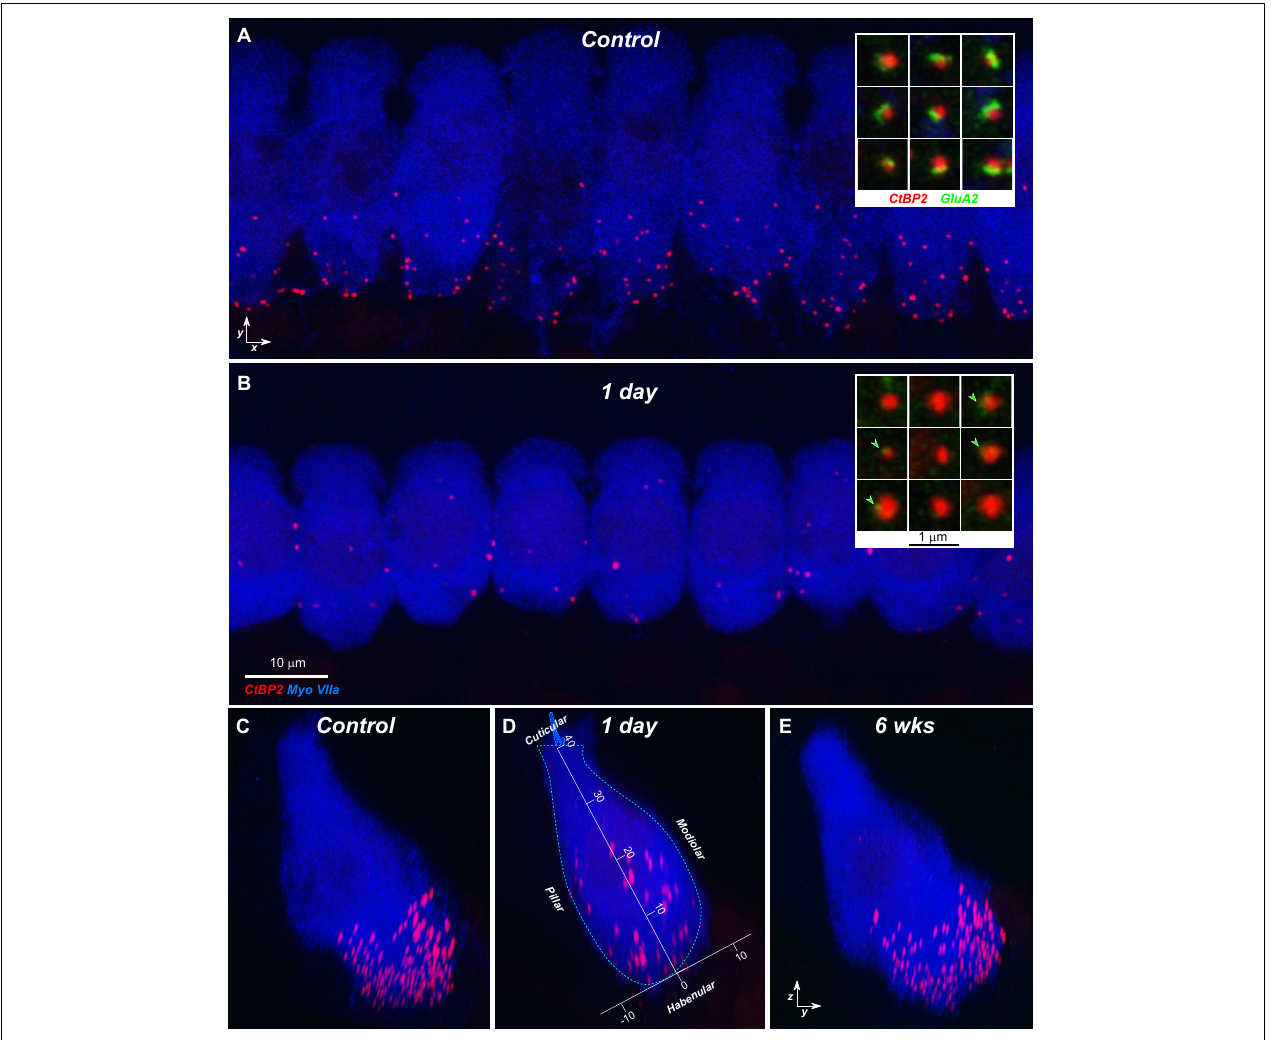
FIGURE 6 | Confocal projections show the loss and recovery of synaptic ribbons after noise exposure. (A,B) Maximum projections from the 22.6 Hz area of nine adjacent IHCs from a control ear (A) and an exposed ear at 1 day post noise (B) . Only the CtBP2 and myosin 7a channels are shown, for clarity. Insets in each panel show nine selected ribbons from the respective z-stack, with only CtBP2 and GluA2 channels visible: arrowheads in (B) show tiny remnants of GluA2 signal in the 1-day post-exposure ear. (C–E) Reprojections of the z-stacks into the zy plane. Panels (C,D) are reprojections of (A,B), respectively; (E) is from an ear 6 weeks post noise. Panel (D) also shows the axis transformation used to superimpose data on ribbon position and size across multiple cases (see Figure 8 ). Scale bar in (B) also applies to (A) ; axis scales in (D) are in microns and also apply to (C,E)